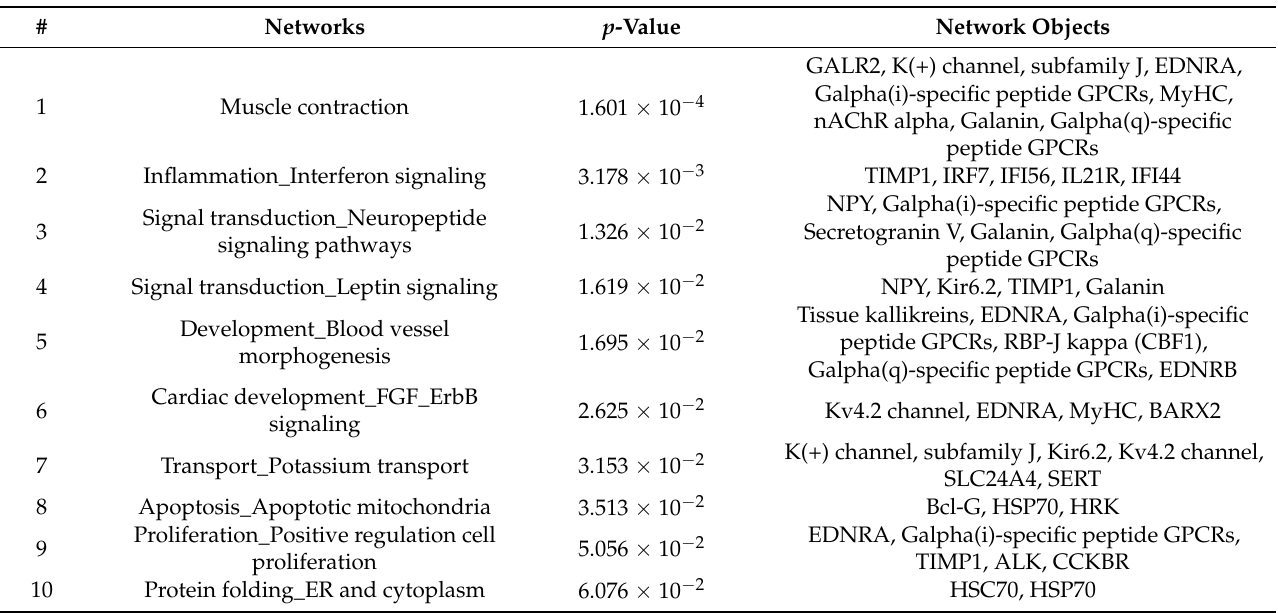
Table 1. Enrichment analysis by process network of differential expressed genes between WT and Abcd1 − /y DRG in RNA-seq using metacore bioinformatics